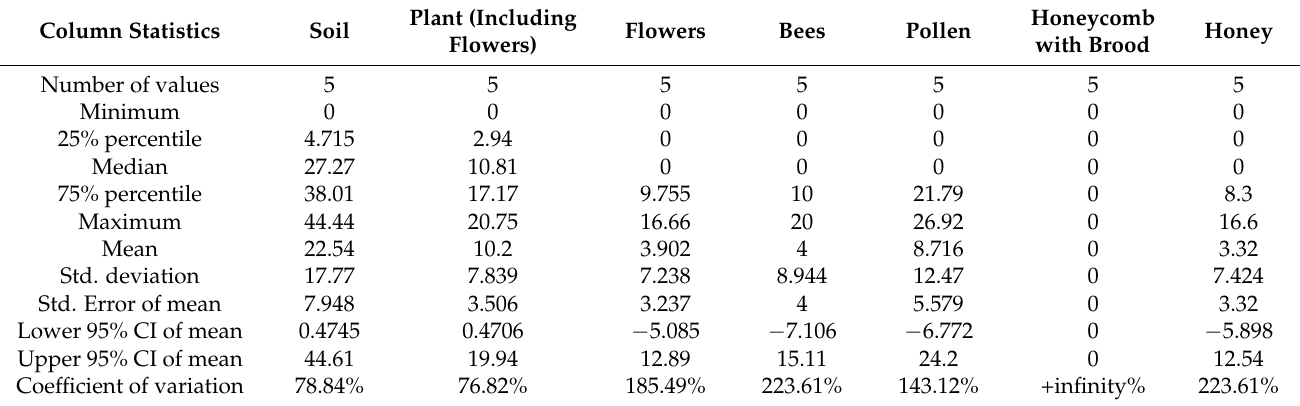
Table 6. Descriptive statistical analyses of NNI-positive